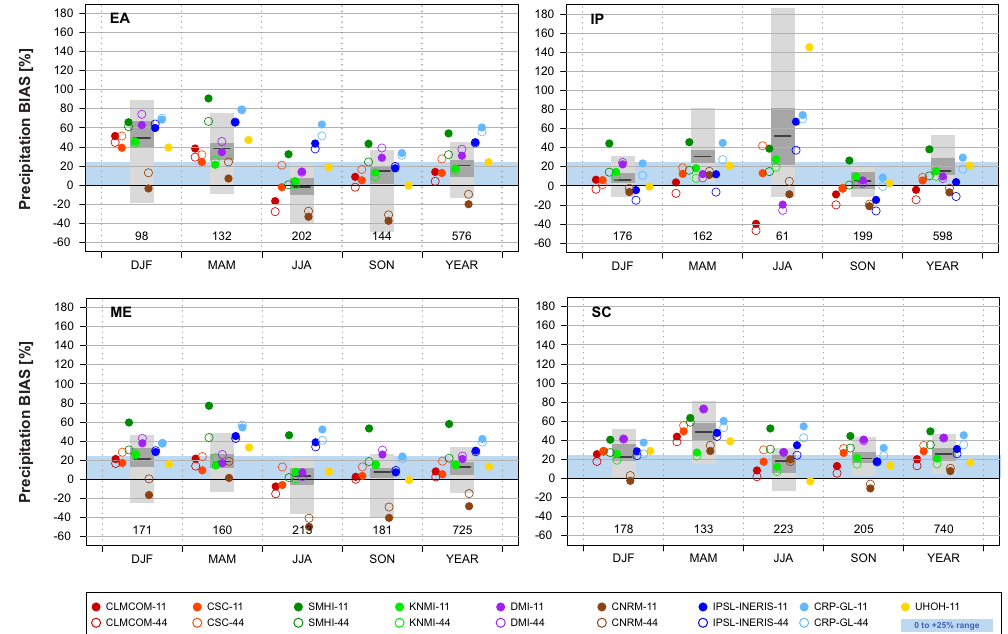
Figure 6. As Fig. 5 but for the mean seasonal and annual relative precipitation bias (BIAS; %). The numbers along the x axis indicate mean seasonal (mmseason − 1 ) and mean annual (mmyear − 1 ) precipitation sums for the period 1989–2008 in the E-OBS reference. The blue shading indicates a bias range between 0 and + 25%, corresponding to acceptable model biases in case of a systematic rain gauge undercatch of up to 20% of true precipitation. See Fig. B2 for subdomains AL, BI, FR and